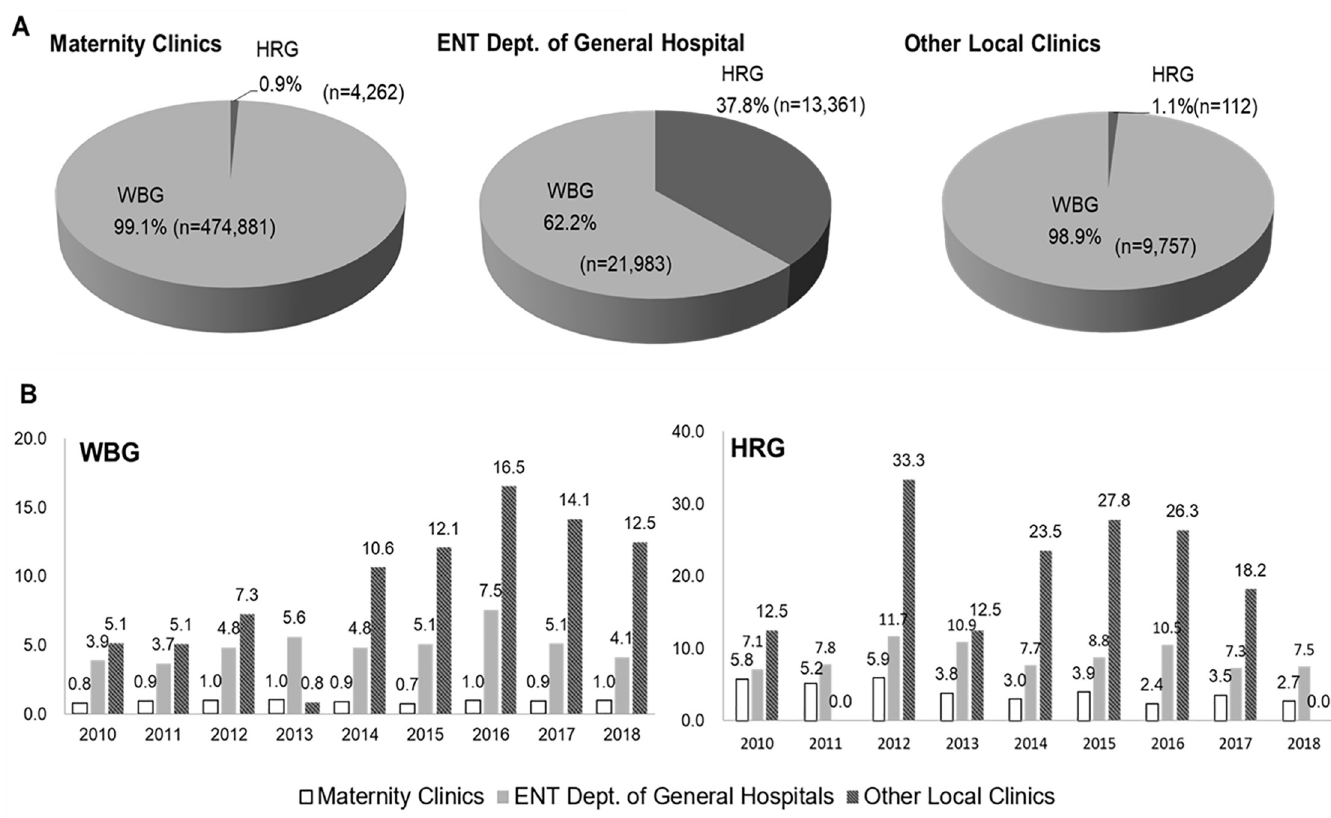
Fig 2. Status of newborn hearing screening in WBG and HRG according to screening hospitals. A. The percentage of WBG and HRG according to screening hospitals. The proportion of HRG was significantly different among three screening clinics and hospitals ( p < 0.001; Pearson’s chi-square test with Bonfferoni correction of 0.017 significance). B. Annual referral rates of WBG and HRG according to screening hospitals. The overall referral rates were significantly higher in the order of other local clinics, ENT department of general hospital, and maternity clinics in both ( p < 0.001). WBG: well-baby group of newborns born healthy or stayed at neonatal intensive care unit (NICU) less than 5 days, HRG: high-risk group of neonates who were hospitalized in the NICU for more than 5 days, ENT: ear, nose, and throat.